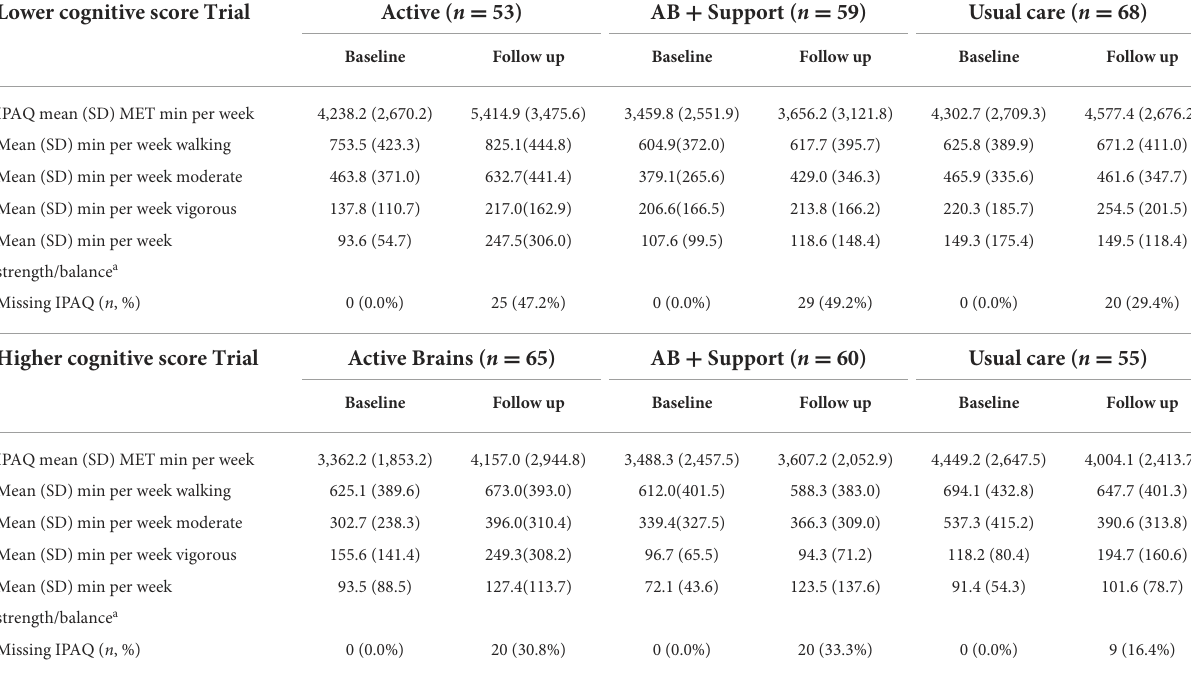
TABLE 6 Baseline and follow-up IPAQ-E (physical activity) data in each trial. Lower cognitive score Trial Active ( n = 53) AB + Support ( n = 59) Usual care ( n = 68) Baseline Follow up Baseline Follow up Baseline Follow